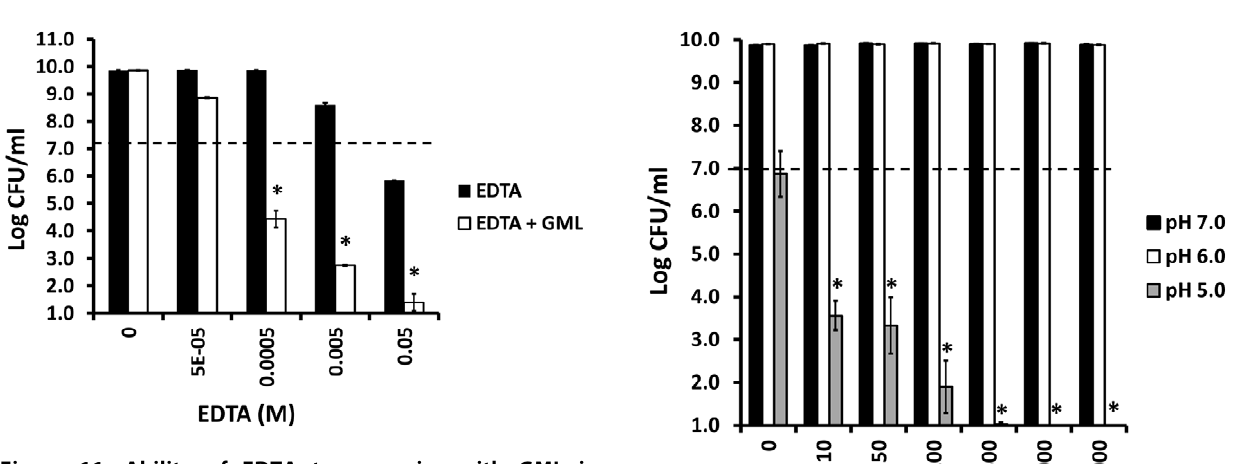
Figure 11. Ability of EDTA to synergize with GML in antibacterial activity against Escherichia coli. Escherichia coli Watson strain was incubated with EDTA or EDTA + GML (100 m g/ml) for 24 hours and then plate counts used to determine CFUs/ml. GML (5000 m g/ml) alone did not inhibit Escherichia coli growth. * indicates mean for EDTA + GML differs significantly from mean for EDTA alone at p , 0.001. Dashed line indicates starting inoculums size.